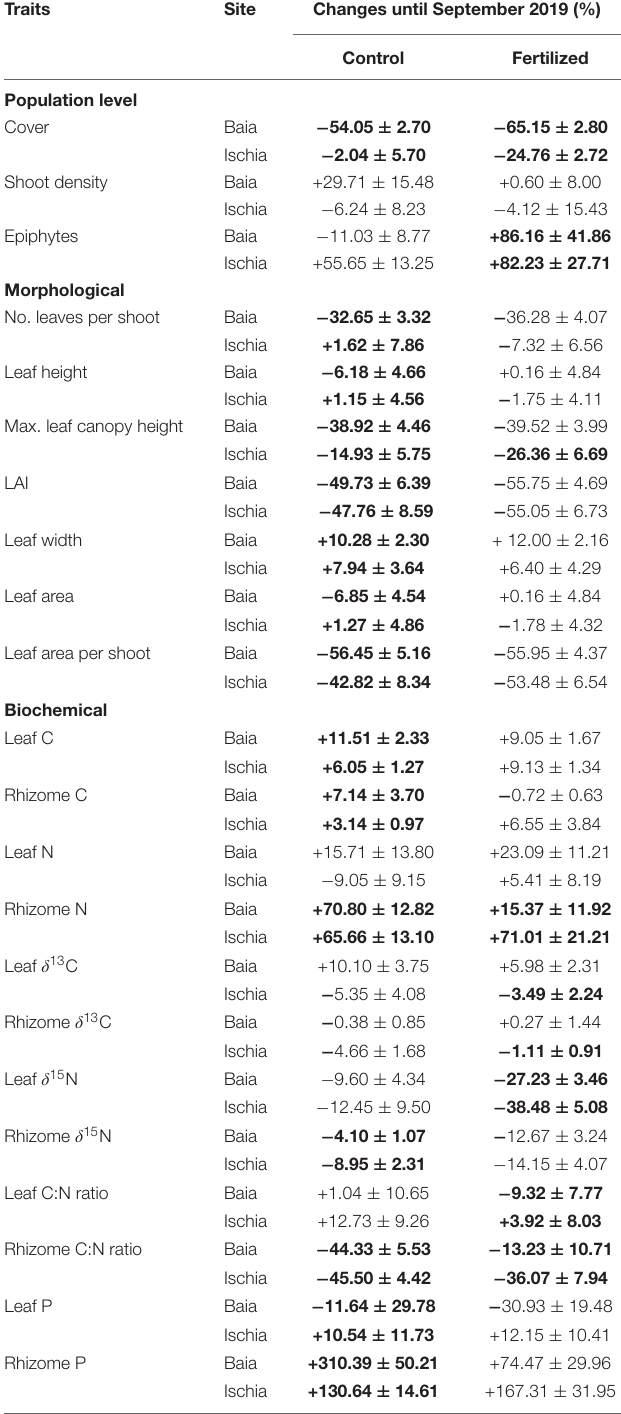
TABLE 3 | Relative percent change (mean ± SE) over the season (shown under Control) and relative percent difference (mean ± SE) with the interactive effects of season and fertilization (as shown under Fertilized) in the measured parameters in rhizome and leaf tissues of seagrass plants in control ( n = 6) and fertilized ( n = 6) plots from the anthropogenically impacted sites (Baia, Gulf of Pozzuoli) and low impacted sites (Ischia) in June compared to control ( n = 6) and fertilized ( n = 6) plots in